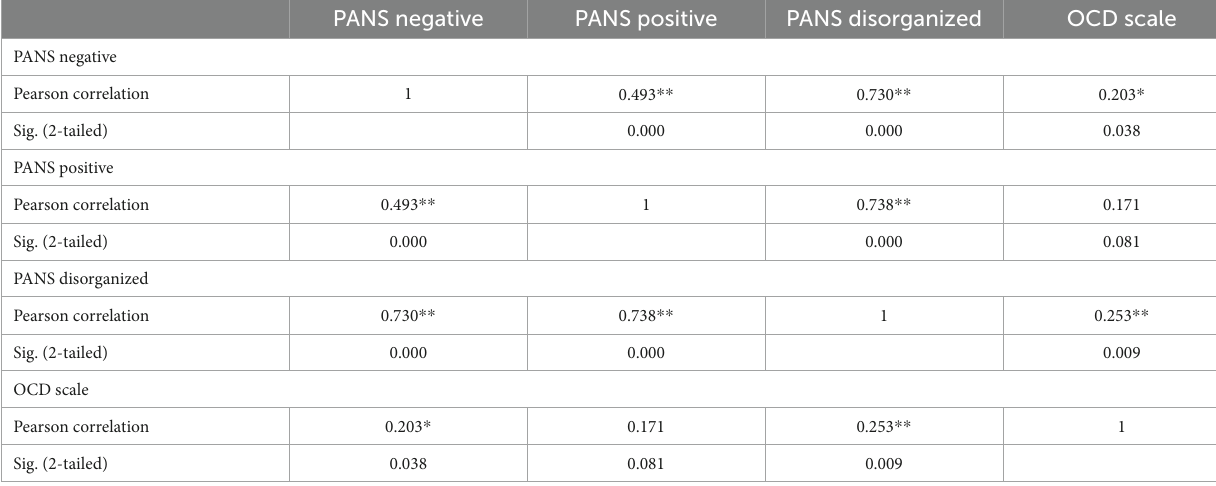
TABLE 3 Relationship between OCS assessed by DOCS and PANSS subscales.